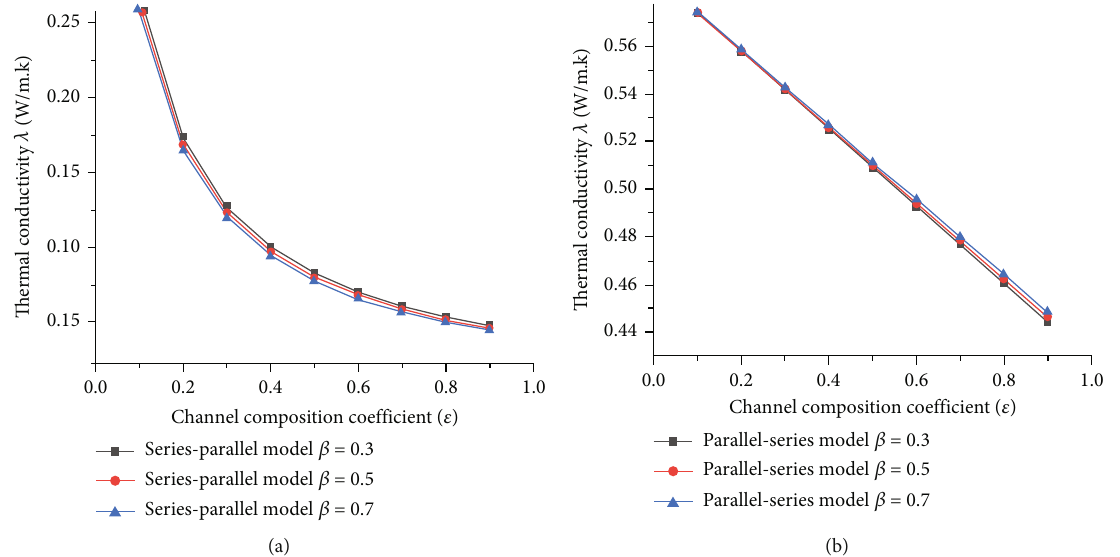
Figure 20: Relationship between thermal conductivity λ and channel composition coe ffi cient ε of integrated REV model with di ff erent water ratio β